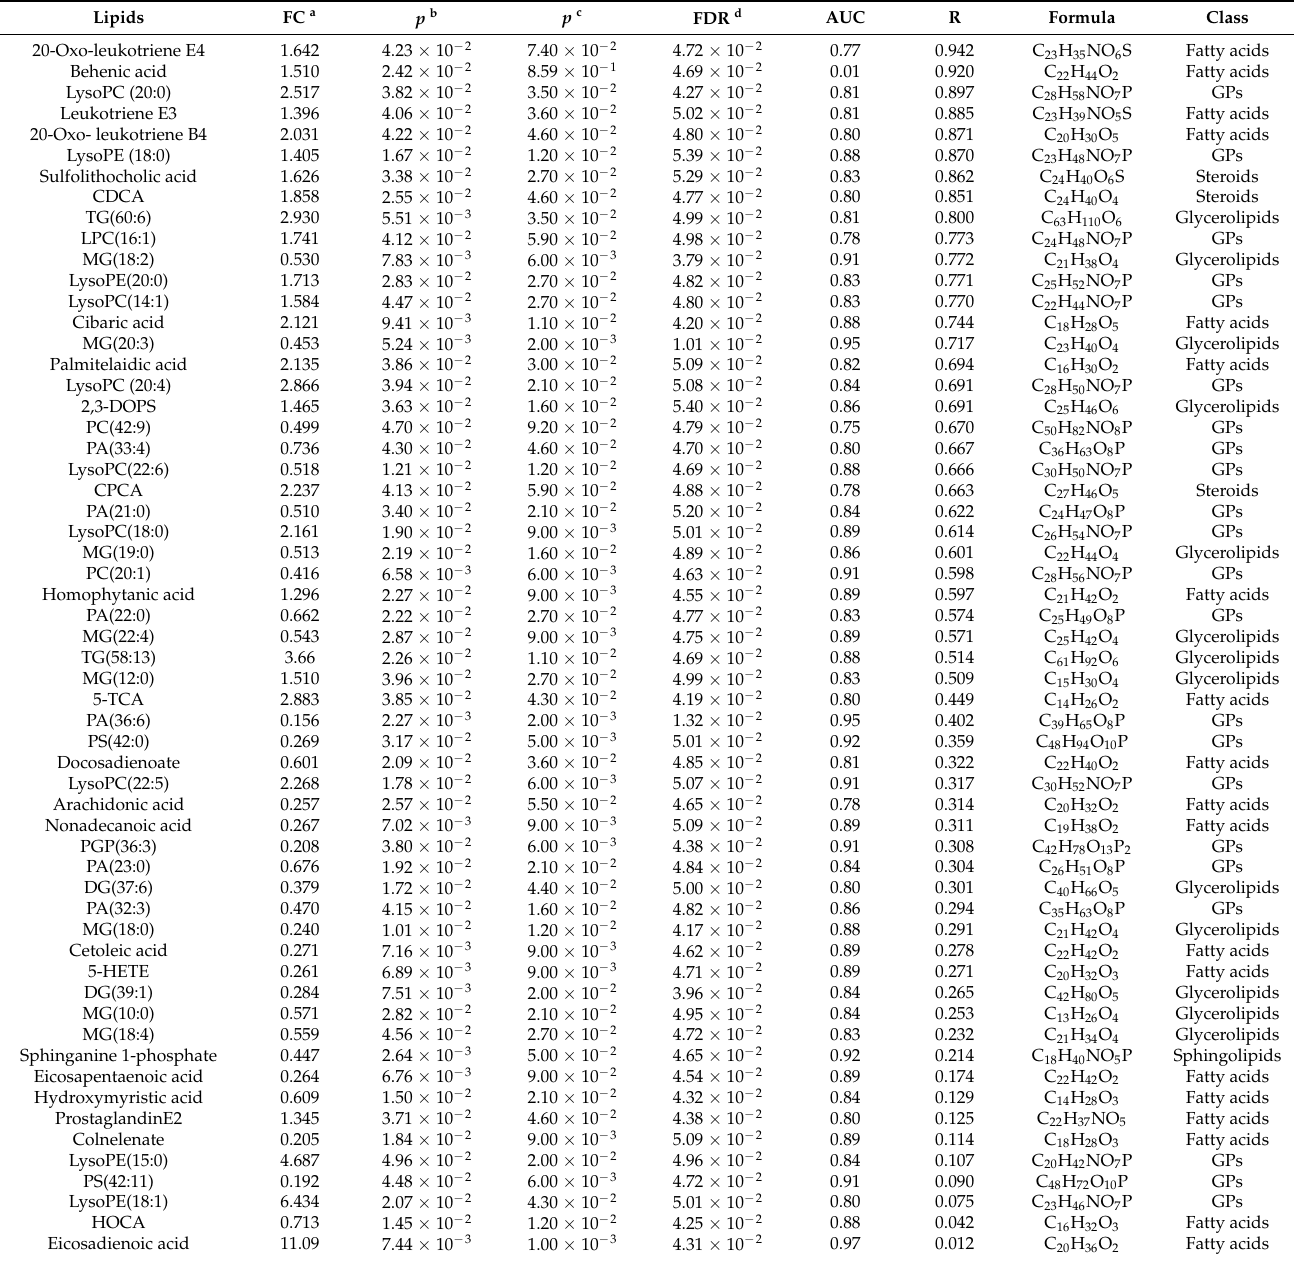
Table 1. Identification of significantly differential endogenous lipids in the rat